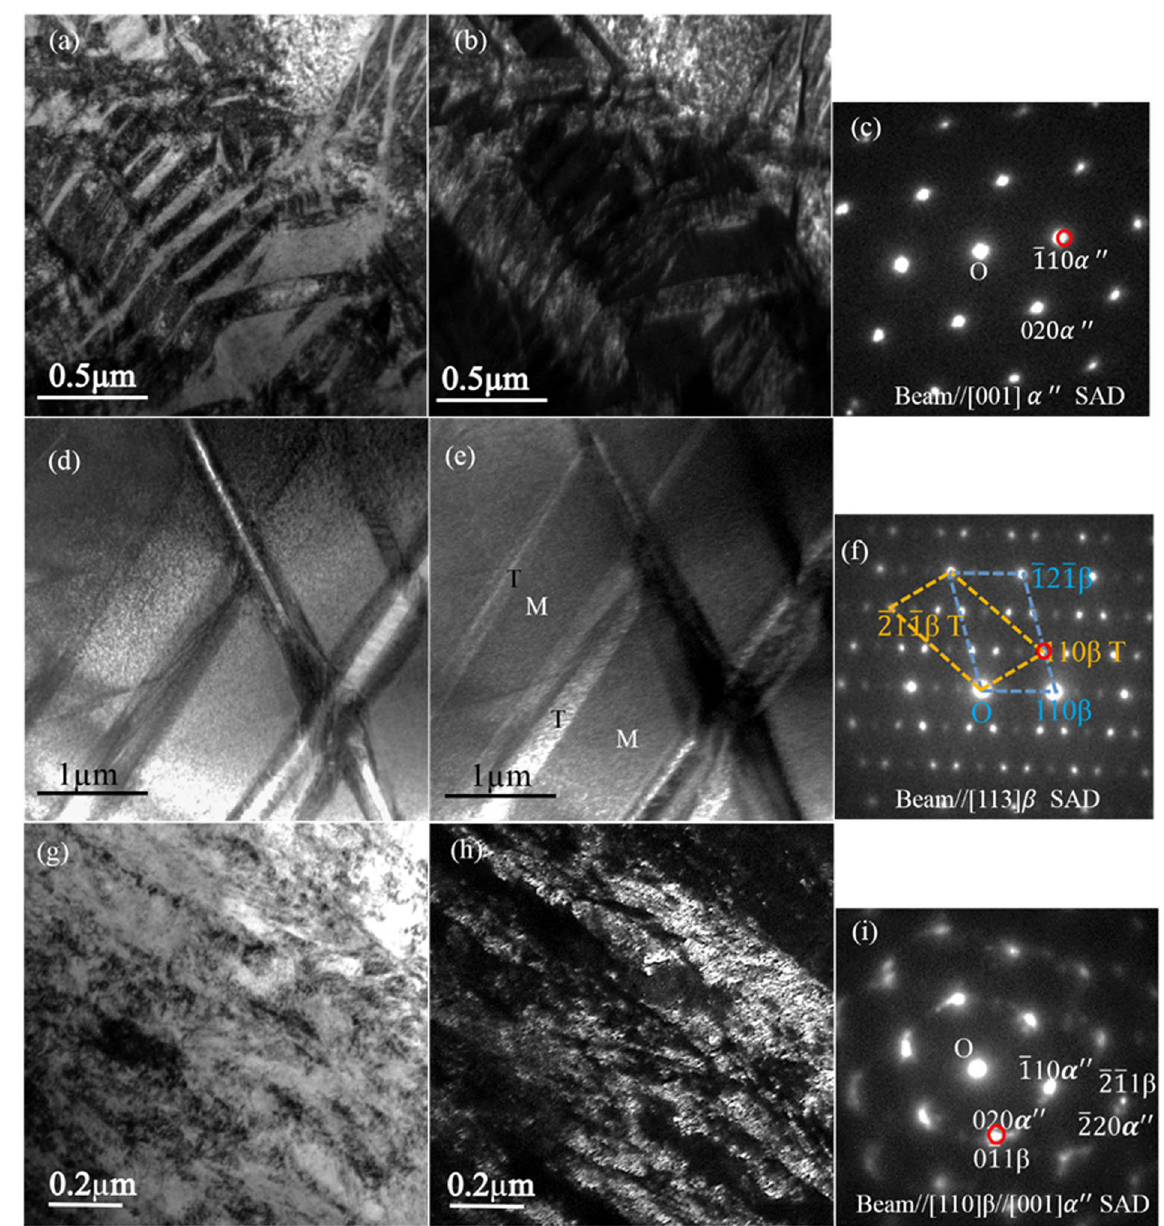
Figure 8. TEM analysis of the 820–5 M alloy deformed to a strain of 2.1% and 38% (after necking), respectively. ( a ), ( b ), ( c ), ( d ), ( e ) and ( f ) for the specimen deformed to a strain of 2.1%. ( a ) BF-TEM image recorded from ultrafine β grain. ( b ) Corresponding DF-TEM image by selecting α ″ ( 110 ) diffraction spot (highlighted by red circle in ( c )). ( c ) α ″ [001] zone axis SAED pattern recorded from the plate-like structure in ( a ). ( d ) BF-TEM image taken from the micrometre-grained β phase. ( e ) Corresponding DF-TEM image recorded from a set of β (110) twinning reflections (red circle in ( f )). ( f ) β [113] zone axis SAED pattern. ( g ), ( h ) and ( i ) for the specimen deformed to a strain of 38%: ( g ) BF-TEM image. ( h ) Corresponding DF-TEM image recorded by selecting α ″ (020), highlighted by the red circle in ( i ). ( i ) SAED